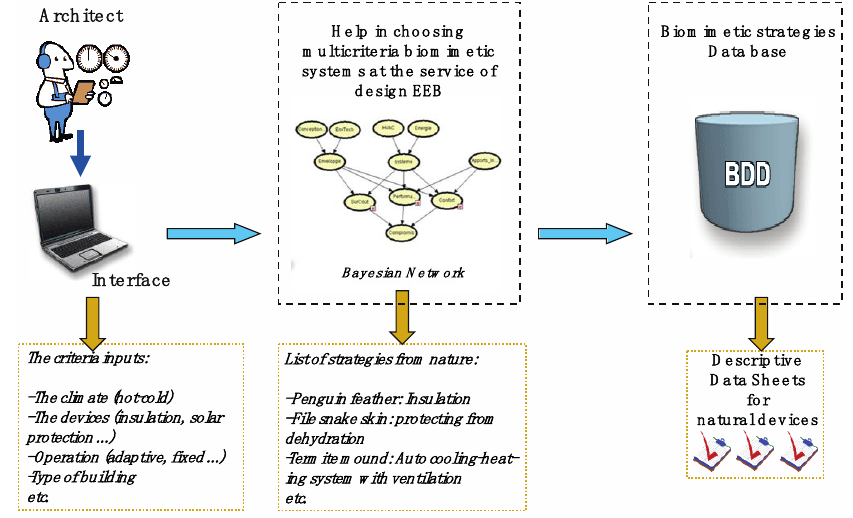
Figure 8. Presentation of the structure of investigating tool, which can support architects to use biomimetic strategies in more applicable way.